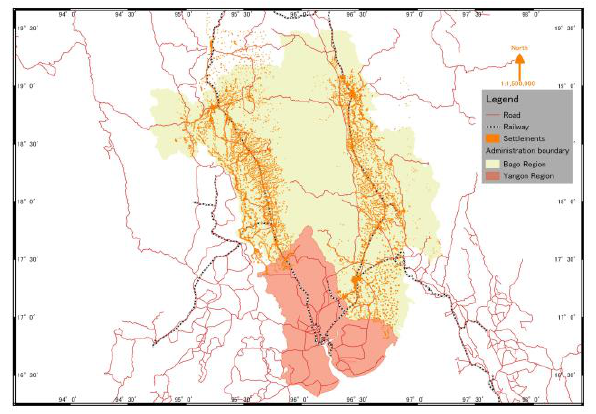
Figure 1: The settlements (orange) of the Bago Region(pale green) neighbour by Yangon Region (orange) Magnificently, population density at Zigon Township is 253 persons per square kilometre, since the area of Zigon is bottleneck between Nattalin and Gyobingauk townships in the region (Table 1) along the Yangon-Pyay Road.